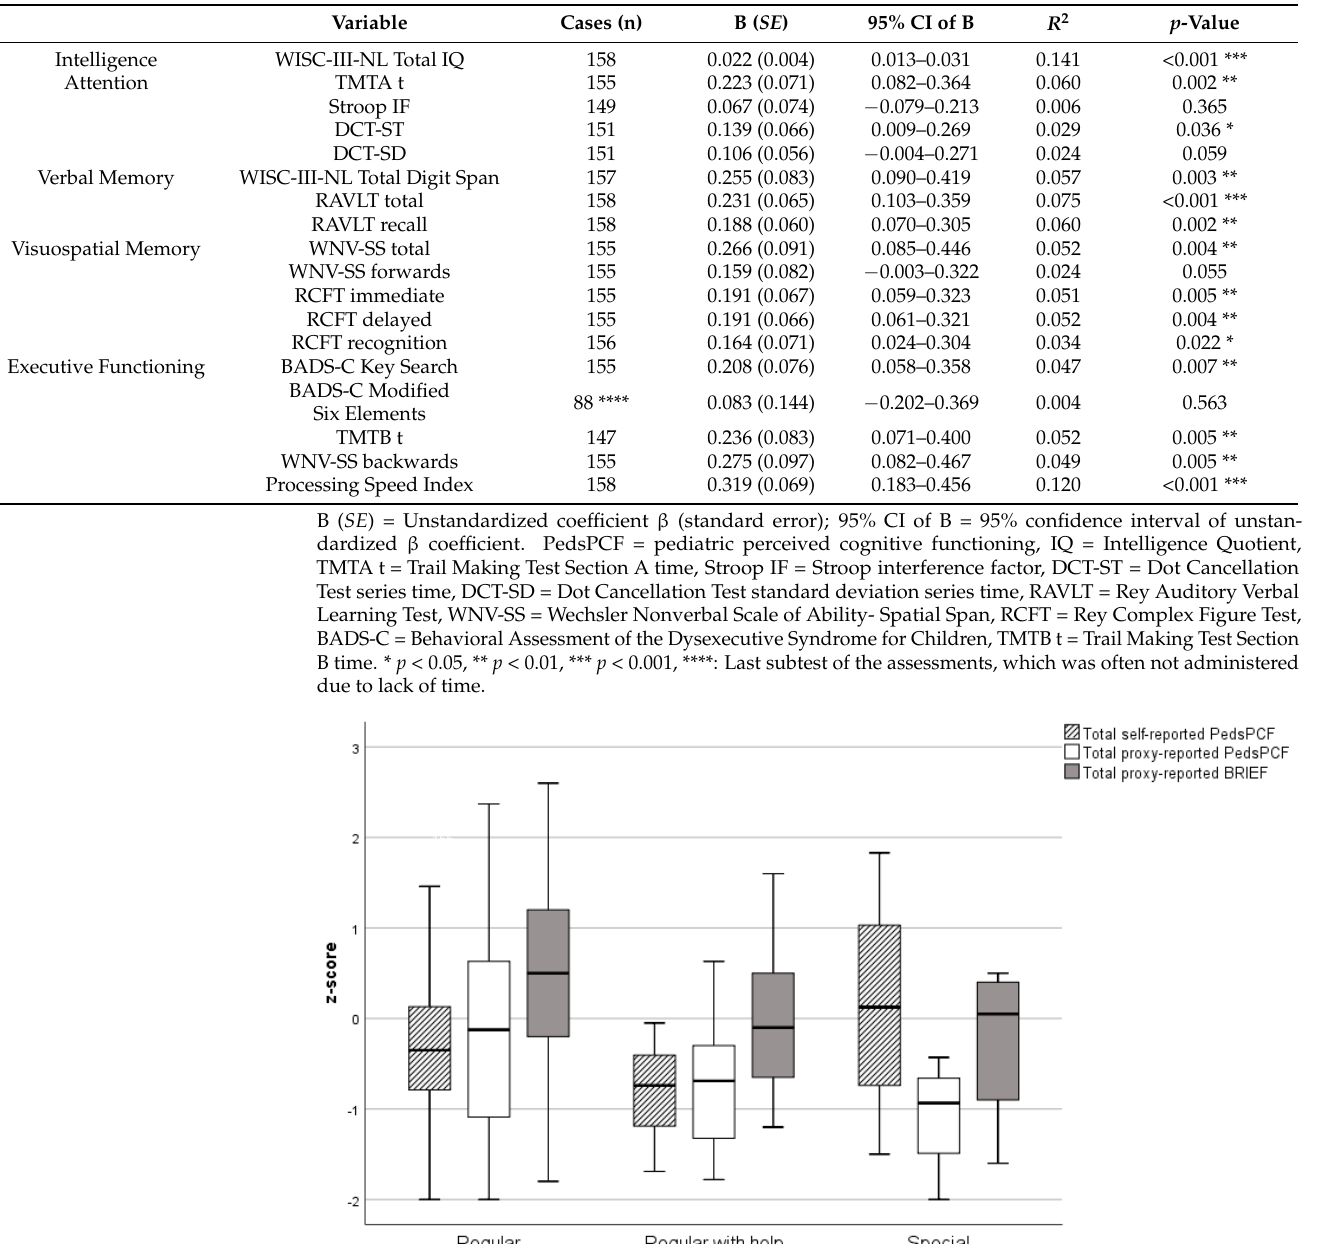
Table 4. Association between proxy-reported PedsPCF score and neuropsychological assessments.